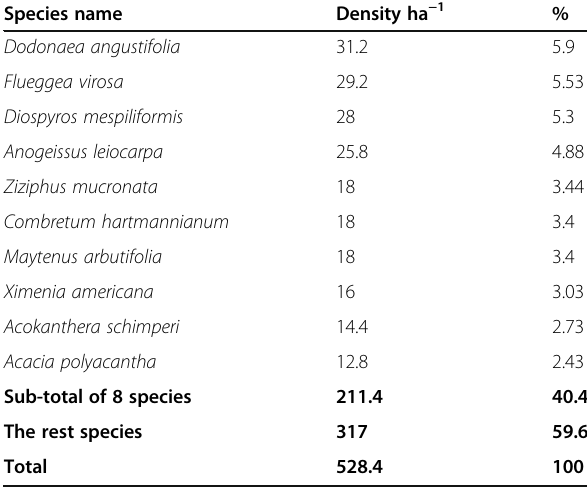
Table 4 Density and percentage contribution of ten woody species in the Hirmi